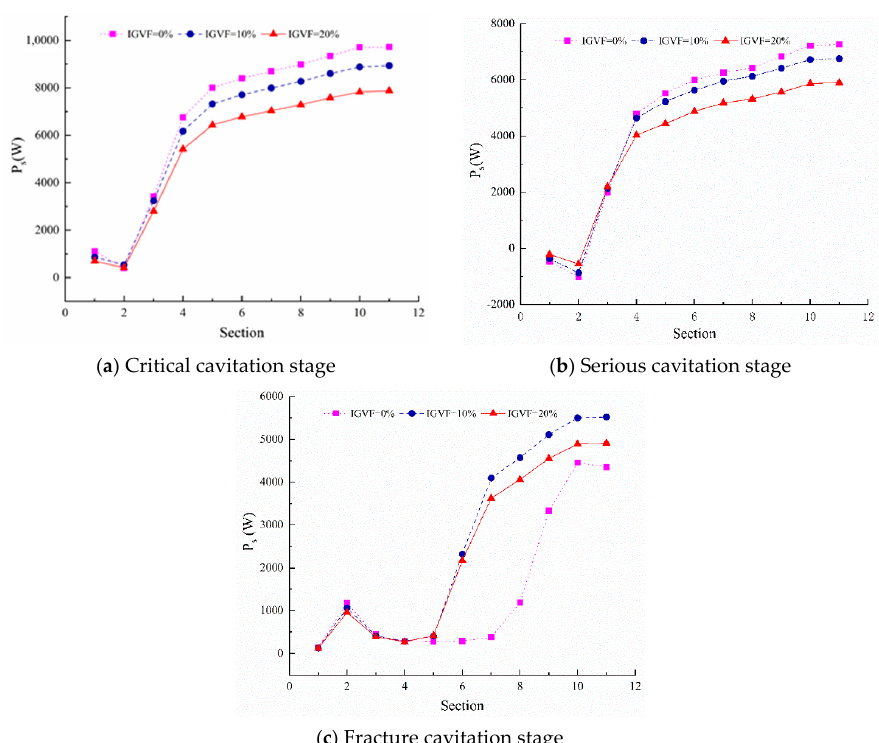
Figure 14. The variation curve of the static pressure power through each section under different IGVFs at each cavitation stage.